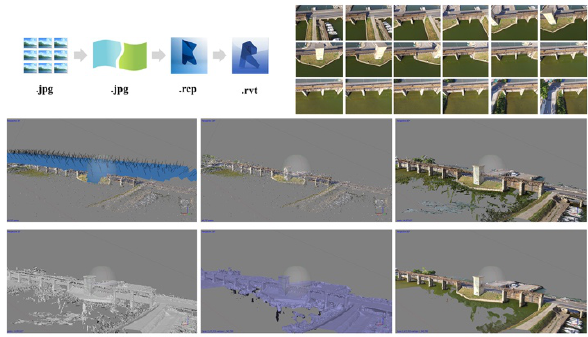
Figure 3. SfM reconstruction of the geometry through